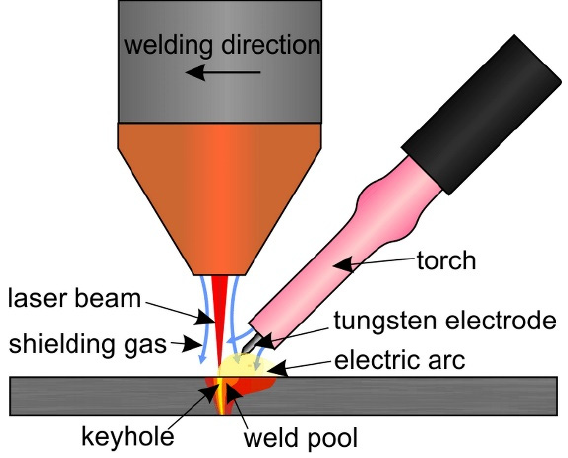
Figure 1. Experimental set-up.